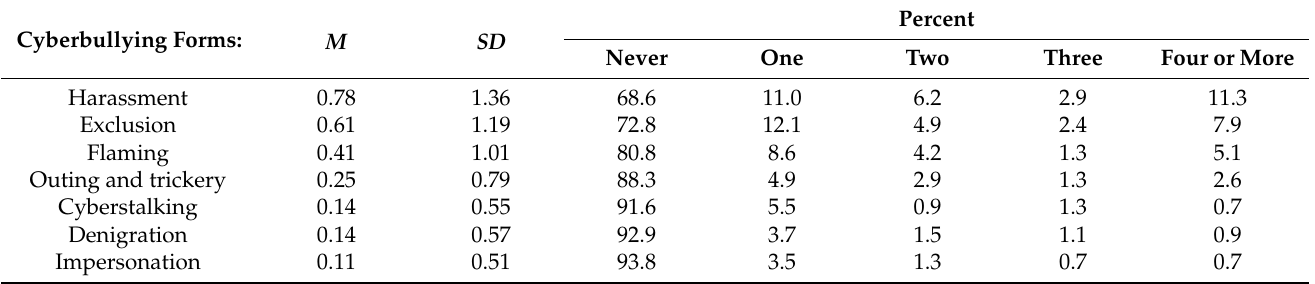
Table 3. Distribution of the respondents according to use of forms of cyberbullying (perpetrator of cyberbullying) (N =